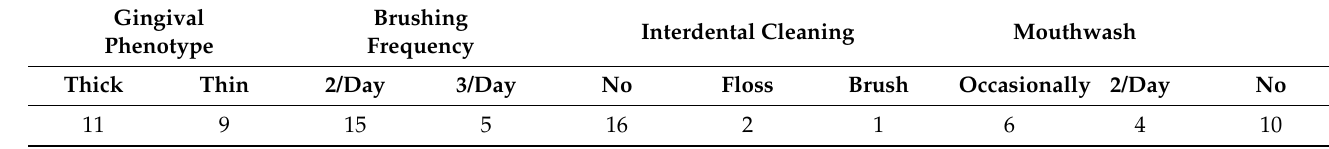
Table 5. Anamnestic data at